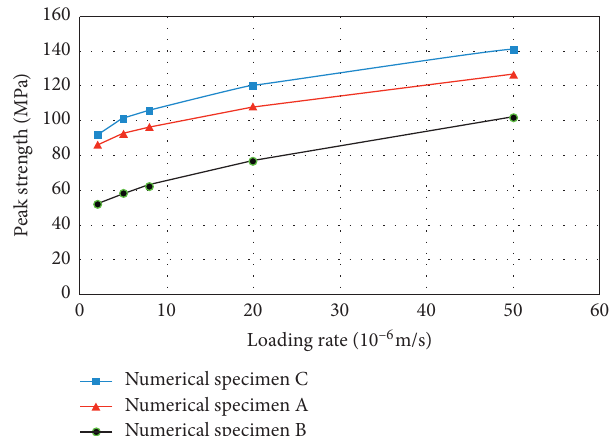
Figure 5: Relationship curve between peak strength and loading rate.